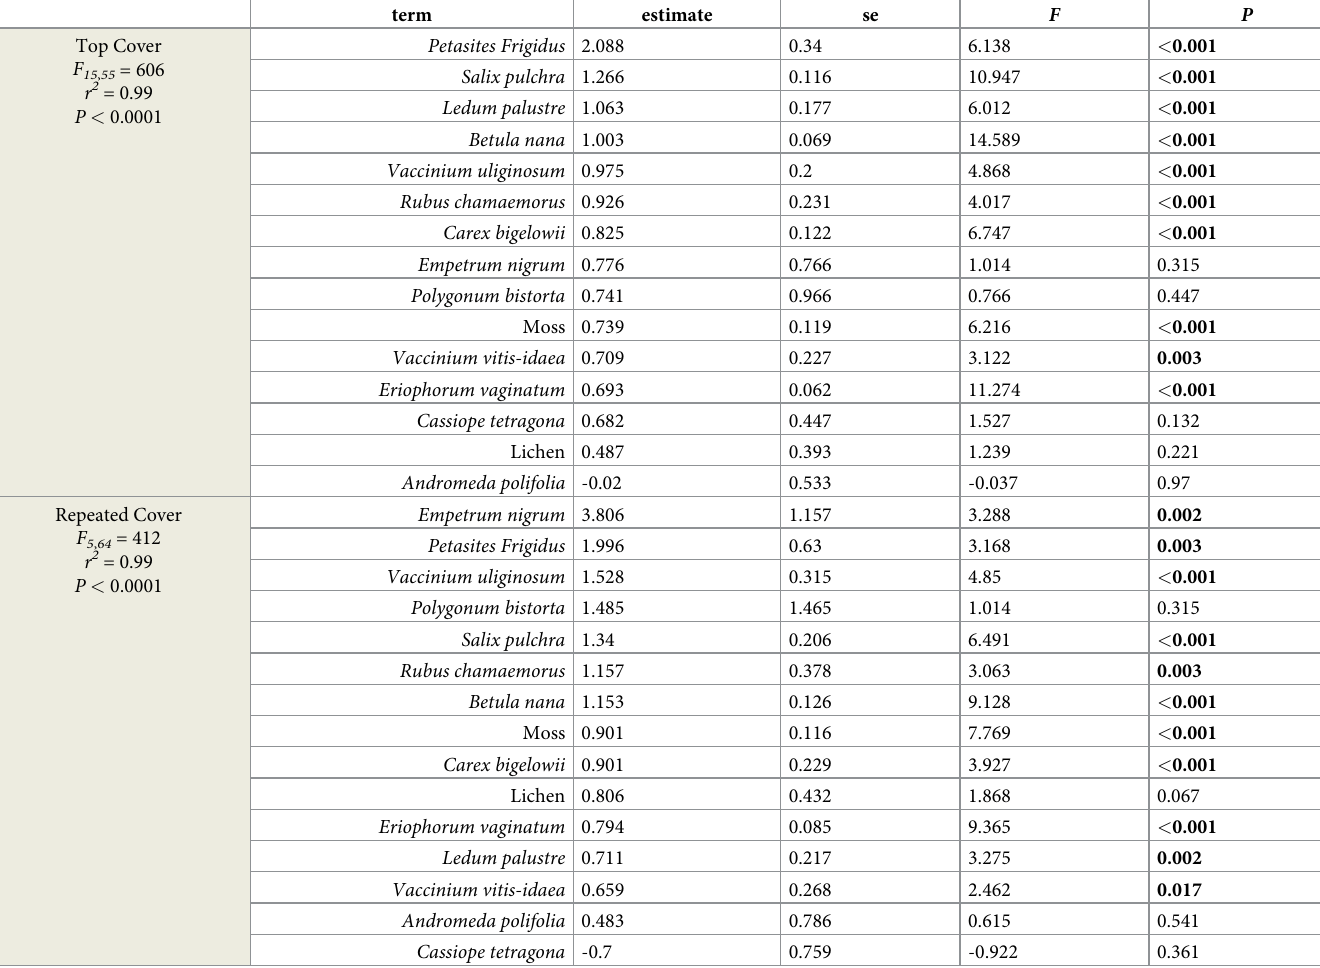
Table 2. Summary of linear mixture models examining the influence of species top cover (proportion of first pin hits) and repeated (proportion of all pin hits) cover on NDVI. term estimate se F P Top Cover F 15 , 55 = 606 r 2 = 0.99